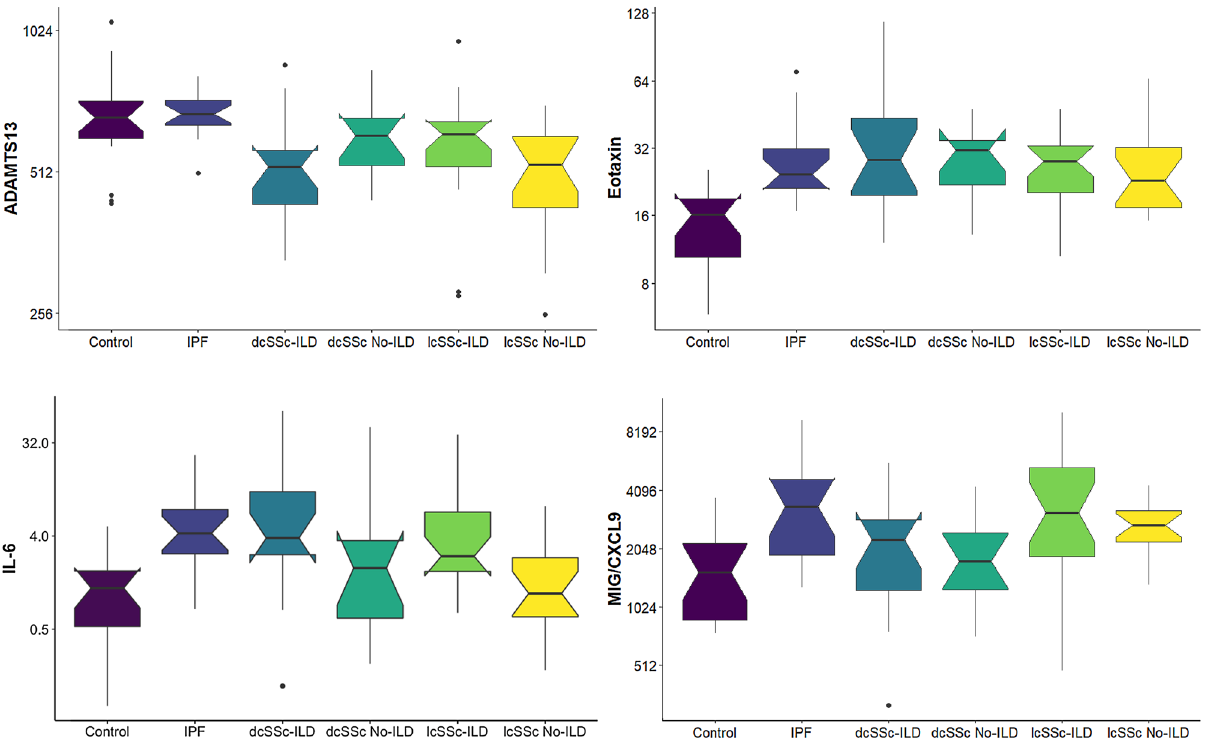
Figure 1. Notched box plots of identified cytokine differences between disease groups. All cytokine levels are shown on a log